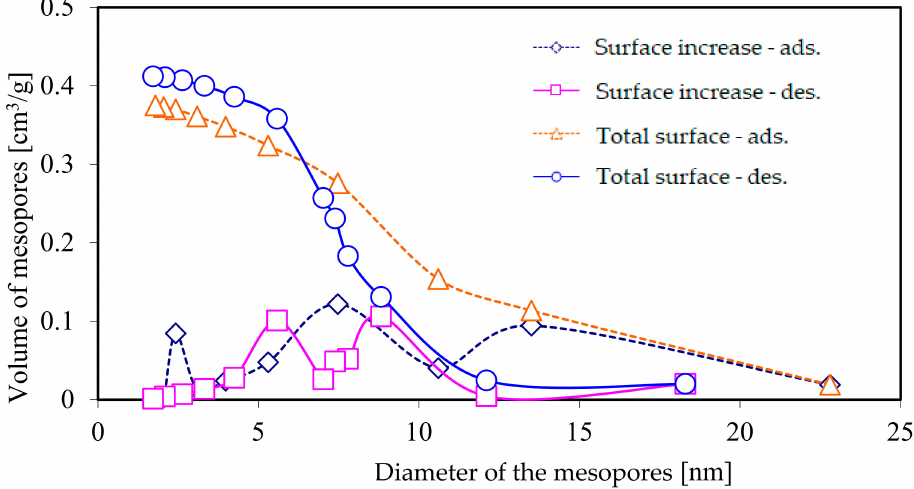
Figure 4. The total volume of mesopores and the increase in the volume of the mesopores as a function of their diameter, as calculated using the BJH method, based on nitrogen adsorption and desorption